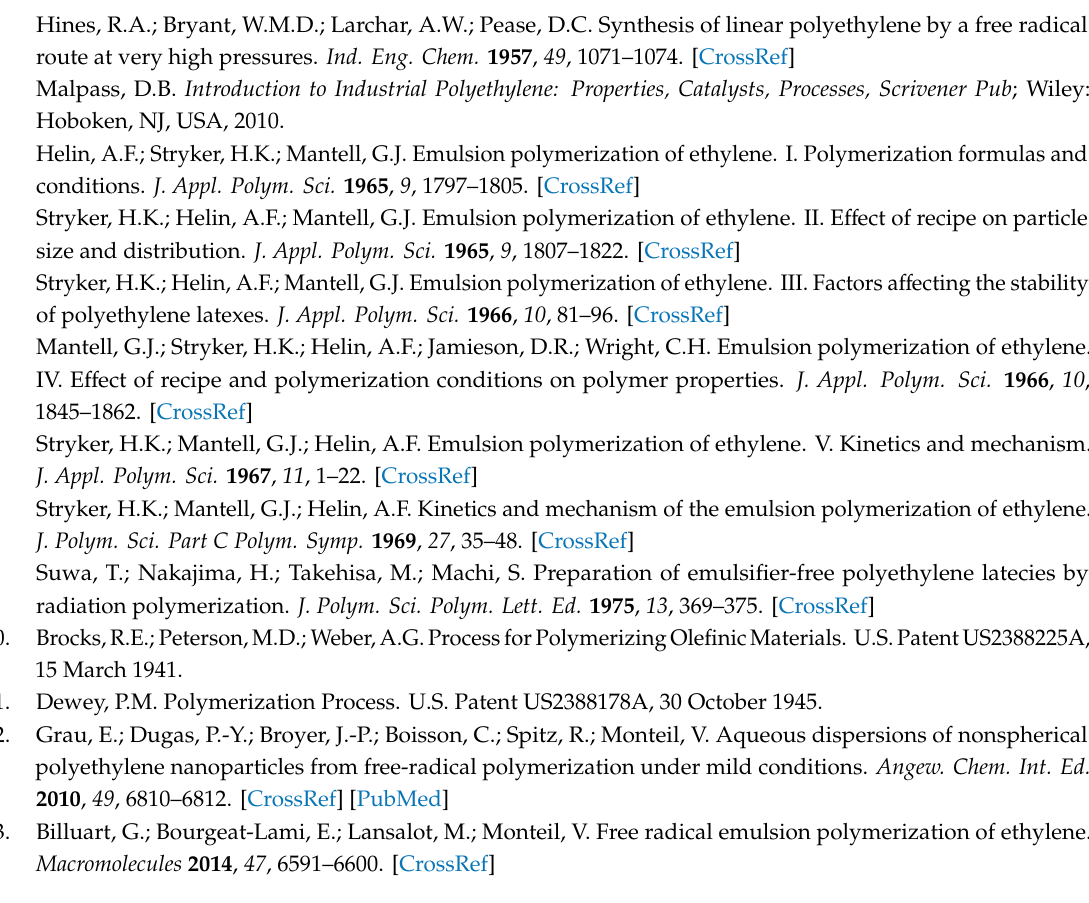
Figure S1: IR spectrum of the formed polyethylene pseudorotaxane via cyclodextrin assisted aqueous radical polymerization of ethylene, Figure S2. 400 MHz 1H NMR spectrum of the polyethylene, produced via CD assist-ed aqueous free radical polymerization, in d6-DMSO, Figure S3: 400 MHz 1H NMR spectrum of the polyethylene, produced via CD assisted aqueous free radical polymerization with the addition of poly(ethylene glycol), in d6-DMSO, Figure S4: IR spectrum of the formed polypropylene via cyclodextrin assisted aqueous radical propylene polymerization, Figure S5. Molar mass distribution of the polypropylene, produced via CD assisted aqueous free radical polymerization, in